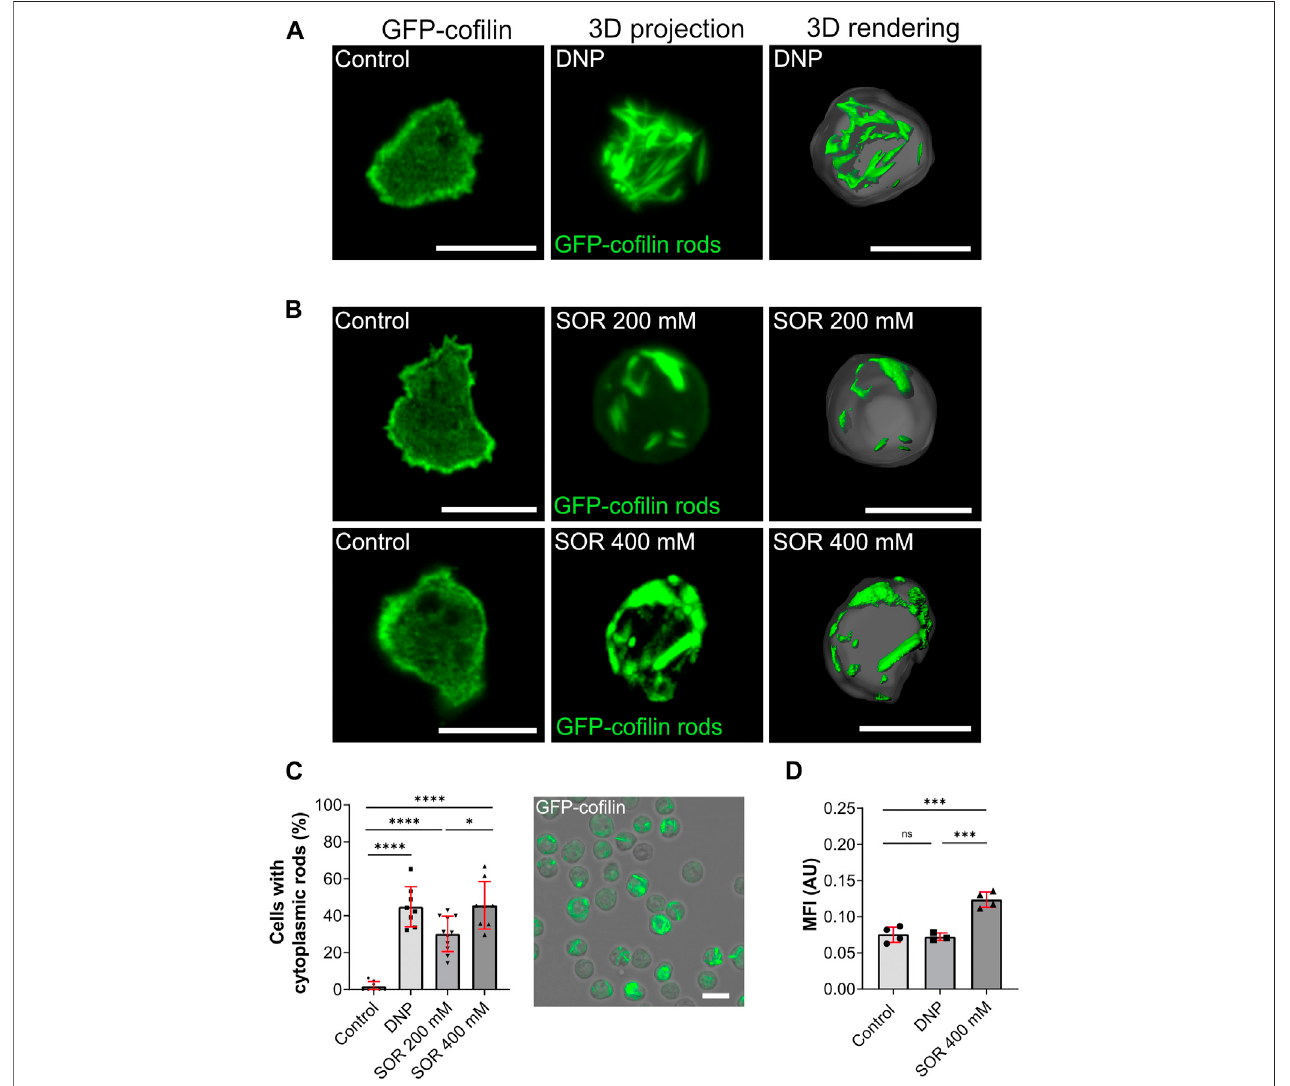
FIGURE 3 | Cytoplasmic actin-co fi lin rods induced by DNP or hyperosmotic shock. (A) Non-treated cells (vehicle control), 3D projection and image rendering of rods formed by GFP-co fi lin expressing cells treated with 200 µM DNP for 2 h. Scale bar, 10 µm. (B) Fluorescent images of non-treated GFP-co fi lin expressing cells (vehicle control) and cytoplasmic actin-co fi lin rods induced by treatment with 200 or 400 mM sorbitol (SOR). Scale bar, 10 µm. (C) Percentage of cells with rods after treatment with DNP or sorbitol for 2 h. Fluorescence image on the right shows a representative overview used for quanti fi cation (212 × 212 µm). For each experiment ( n > 6), 10x overview images were quanti fi ed. Scale bar, 10 µm. (D) Ratiometric fl uorescence measurements show a drop in the intracellular pH after treatment with 400 mM sorbitol for 2 h. Histograms depict median fl uorescence intensity (MFI). More acidic values result in higher MFI. Error bars are median with interquartile range (red). Samples were considered signi fi cant when p ≤ 0.05. Welch´s t-test was applied. n (cid:2) 3-4 experiments; more than 20 cells were analyzed per experiment, and the average of fl uorescence intensity was determined.